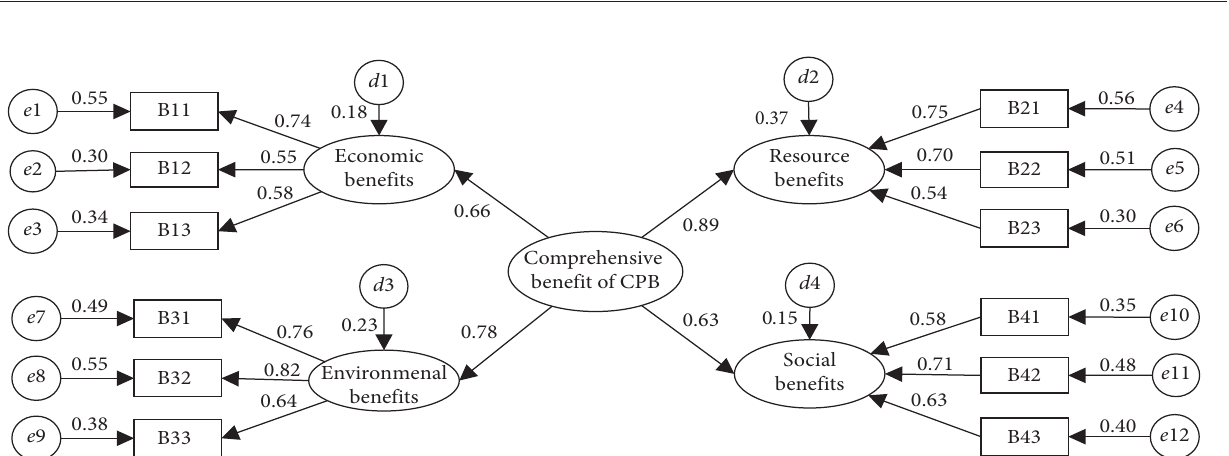
Figure 2: Second-order confirmatory factor analysis model.